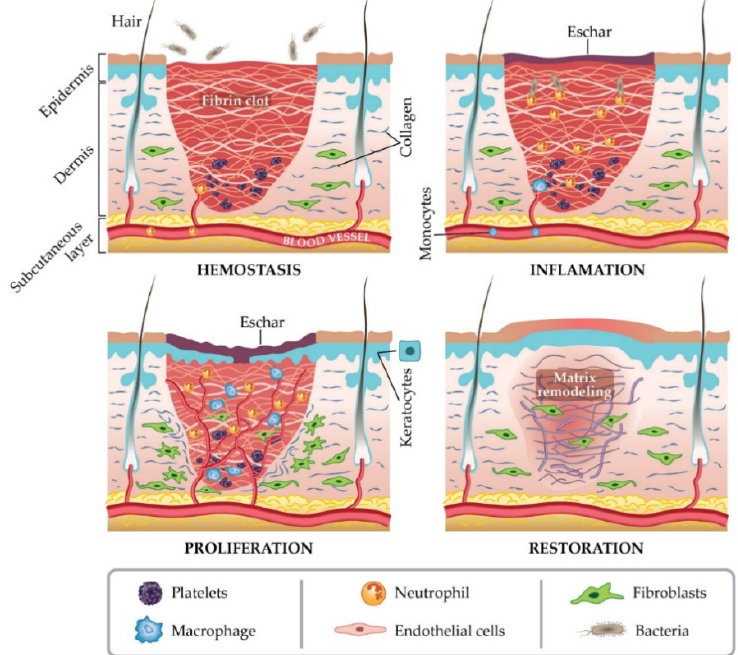
Figure 1. Stages of wound healing. Adapted from I. Negut, V. Grumezescu, A.M. Grumezescu, Treatment strategies for infected wounds, adapted from [18].